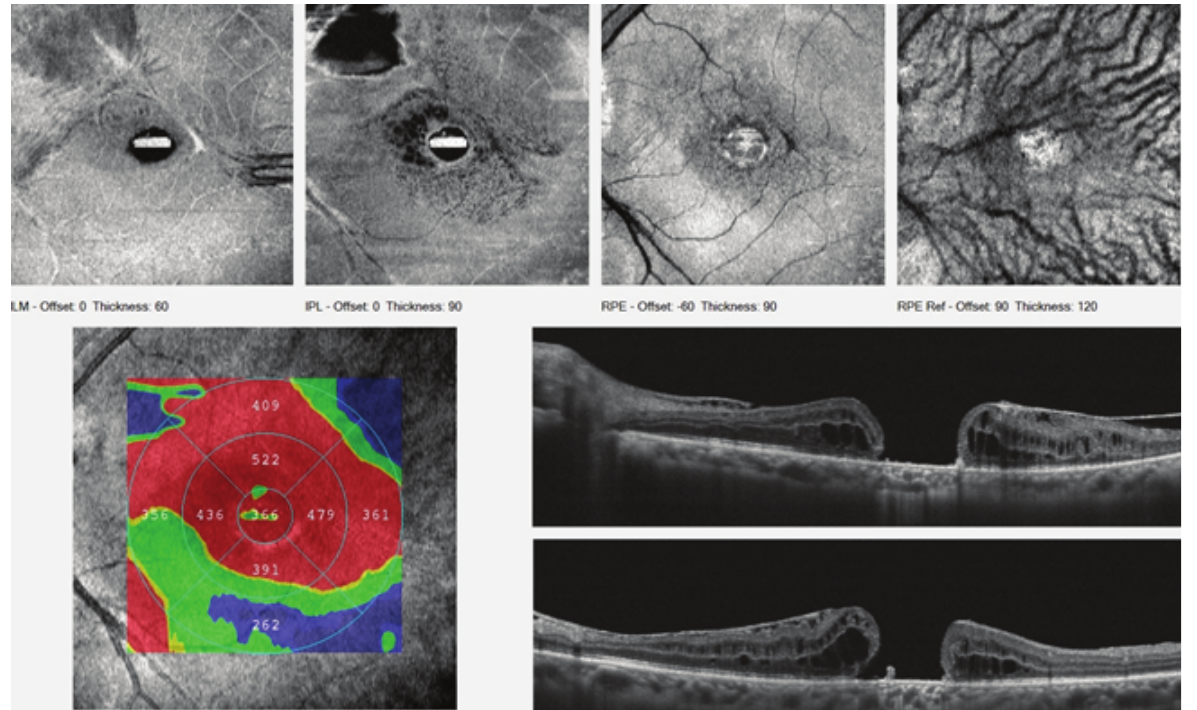
Figure 4. Patient 2; preoperative OCT cross-line horizontal and vertical scans of the macular hole; plus enface images of the macular hole.